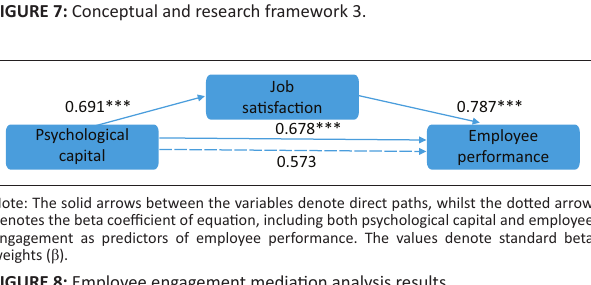
Job satisfaction FIGURE 7: Conceptual and research framework 3.